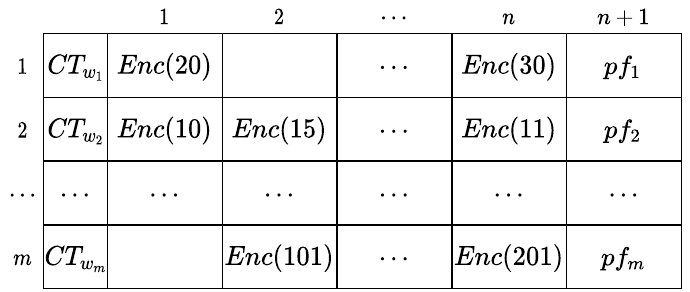
Figure 4. The encrypted verification index